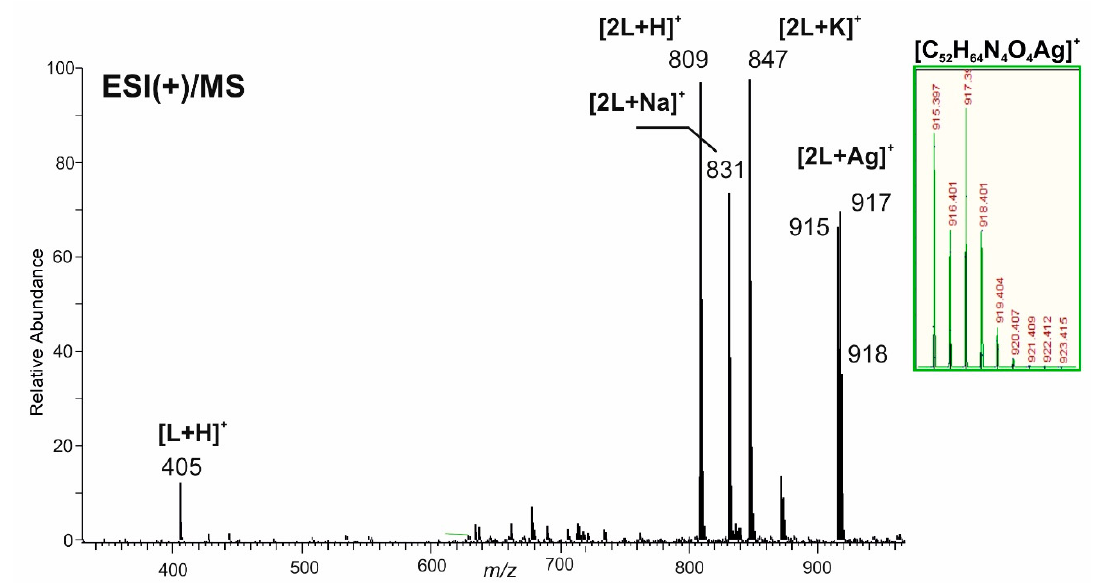
Figure 3. ESI ( + ) mass spectrum of a solution of [Ag( VI L) 2 ]Cl ( 10 ) in acetonitrile. The insert shows the theoretical isotopic pattern of the cation [Ag( VI L) 2 ] + i.e., [Ag(C 26 H 32 N 2 O 2 ) 2 ] + .